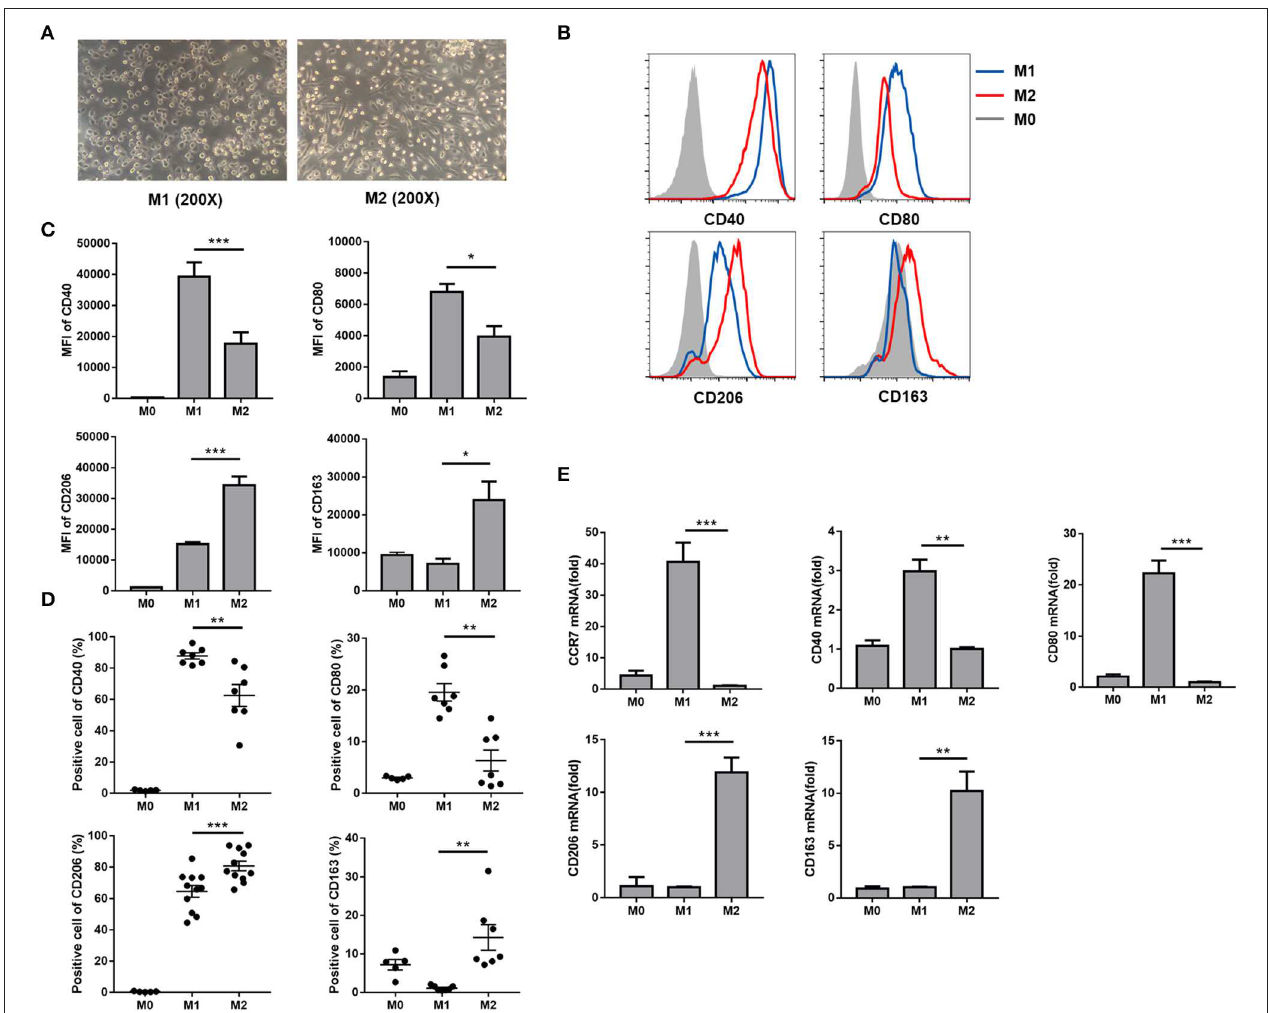
FIGURE 1 | Comparison of human peripheral monocyte-derived M1 and M2 macrophage polarization profiles. (A) After M1 and M2 M Φ were eventually polarized upon an additional 24h incubation with LPS/IFN- γ or IL-4, the morphology of M1 and M2 M Φ were observed using light microscope (original magnification, × 200). (B) Representative flow cytometric graphs showing CD40, CD80, CD206, and CD163 expression levels in M1 and M2 M Φ . Cumulative results calculating MFI (C) and positive cells (D) of CD40, CD80, CD206, and CD163 expression levels in freshly isolated monocytes (M0), M1, and M2 M Φ . (E) CCR7, CD40, CD80 (upper), CD206, and CD163 (lower) mRNA levels in M0, M1, and M2 M Φ were analyzed by RT-qPCR. Experiments in (B–E) were repeated at least two times. Data were analyzed using a paired Student’s t -test. Results are shown as the mean ± SEM ( B–D , n = 6–11; E , n = 3). * p < 0.05, ** p < 0.01, *** p <